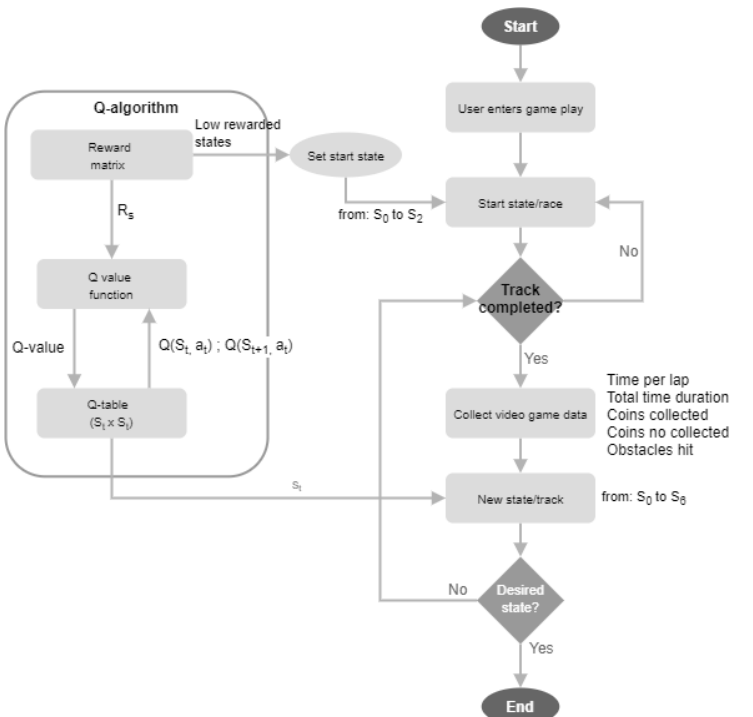
Figure 12. The virtual environment adapts to the user’s preferences by accessing the desired parame- ters at the user preference acquisition stage.